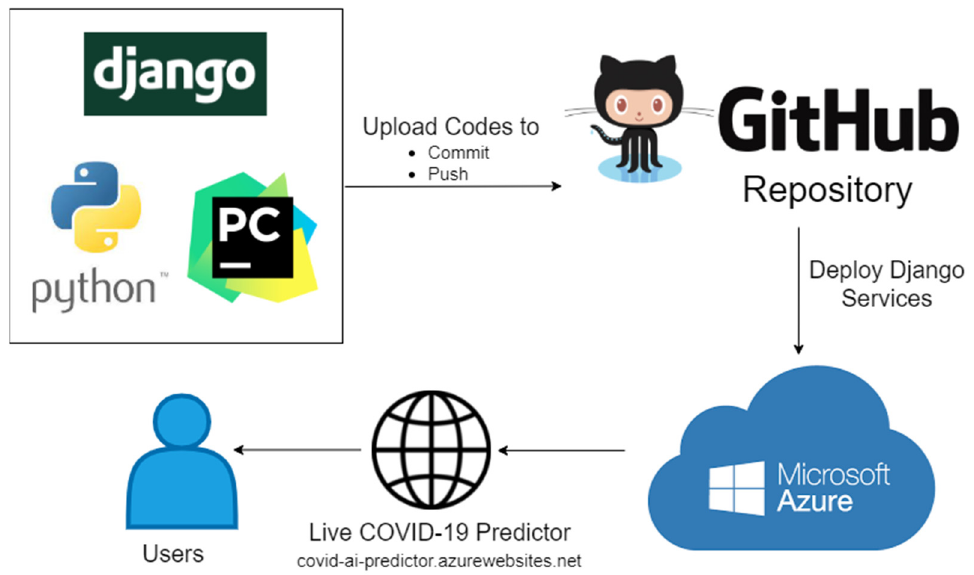
Figure 8. The process of deploying the web application in GitHub Repository and Microsoft Azure.